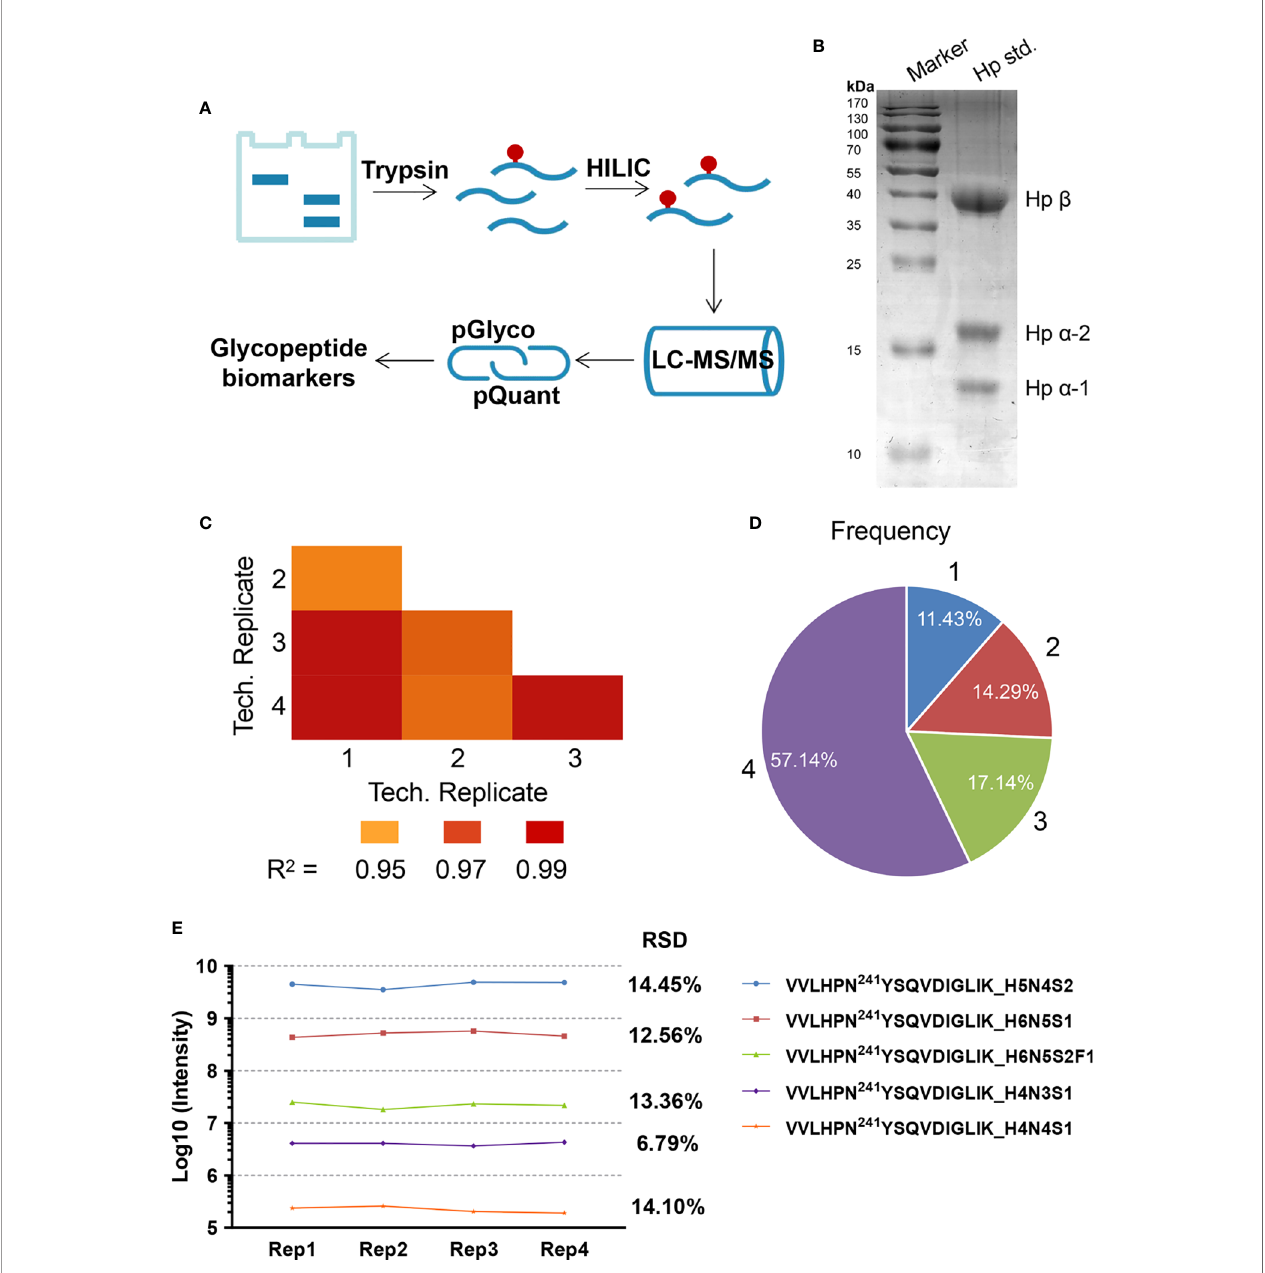
FIGURE 1 | (A) Work fl ow for label-free quanti fi cation of N-glycopeptides. (B) Standard haptoglobin (Hp) was separated by 1D gel. (C – E) Reproducibility analyses of four technical replicates performed at four different times. (C) The Pearson Correlation Coef fi cient R 2 values in technical repetition. (D) The frequency of N-glycopeptide identi fi cation in technical repetition. (E) The reproducibility of glycopeptide intensity at N241 site in the four technical